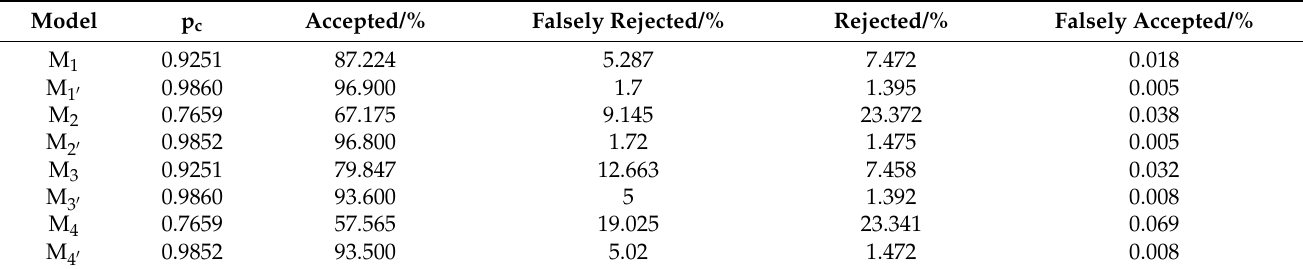
Table 2. Conformance probabilities for the straight, outer side of the pipes.